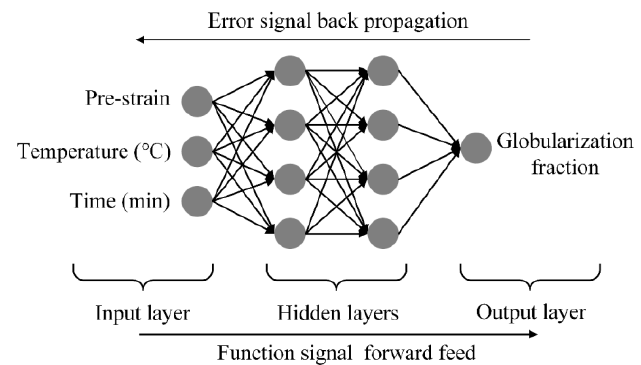
Figure 3. Schematic diagram of the BP-ANN model of static globularization.